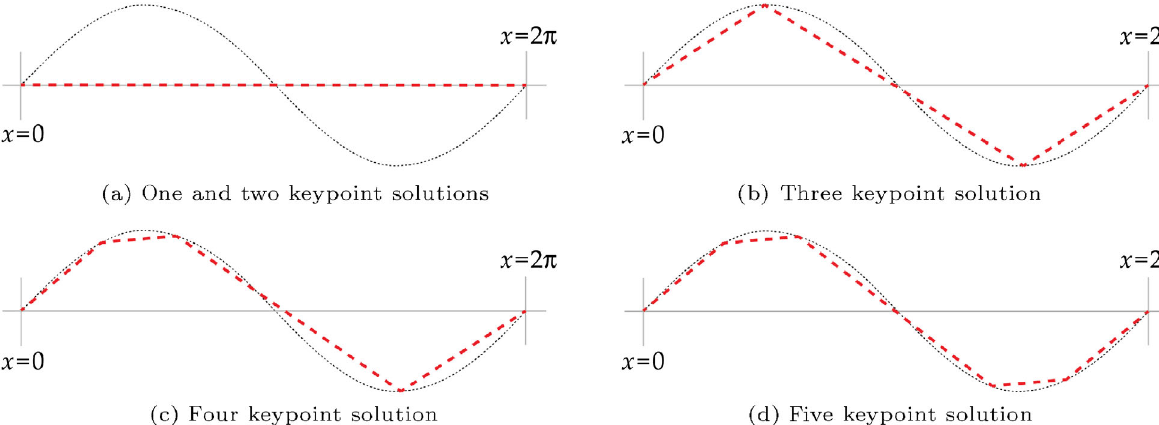
Fig. 19 The error between a piecewise linear interpolation of keyframes and the original motion may decrease irregularly as more keyframes are used. This lack of proportionate error reduction can be explained intuitively using this example of a sinusoid. Take the canonical sinusoid sin( x ) through the interval [0 , 2 π ]. First, note that optimal solution for both the one keypoint and two keypoint linear approximation features the same flat line (a). The optimal three keypoint solution (b) captures both extrema and, consequently, the error reduces significantly. In contrast to the optimal three keypoint solution, the optimal four (c) and five (d) keypoint solutions reduce error only slightly. From this example, we can see that error reduces irregularly with increasing numbers of keypoints. Notably, the error cliff phenomenon (see text) occurs with the three-piece solution. As articulated motion tends to follow smooth trajectories, at least at a coarse scale, it is unsurprising that a similar error cliff pattern is seen with piecewise linear approximations. Intuitively, an error cliff occurs as enough keyframes become available to capture all extrema for a given level of